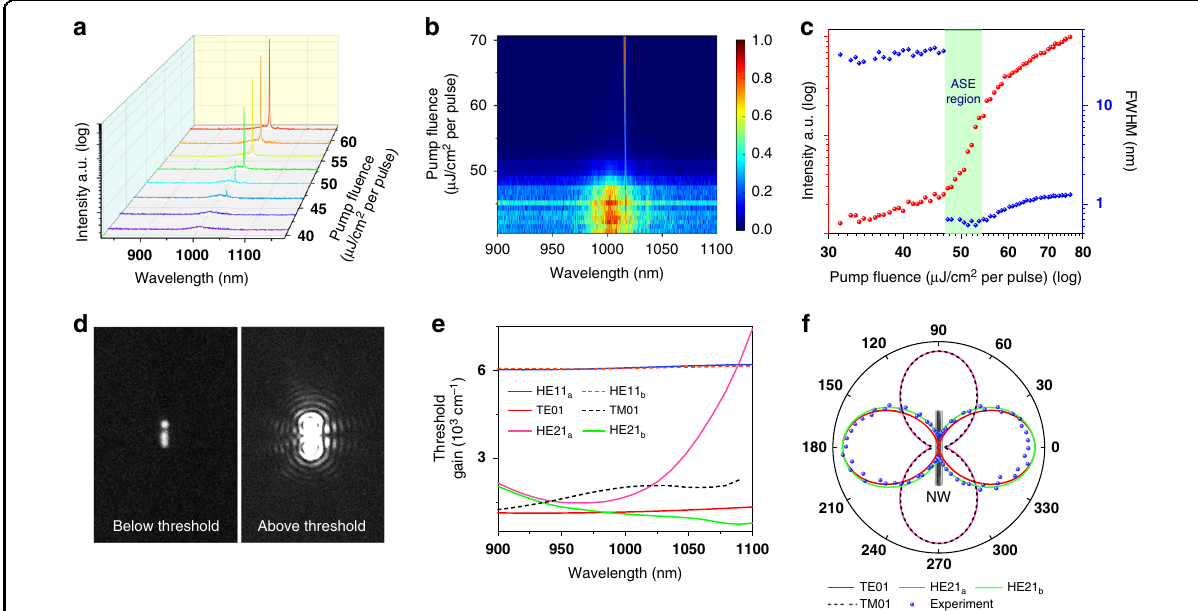
Fig. 2 Lasing characteristics and mode identi fi cation of the NW laser. a, b Emission spectra of the NW with increasing pump fl uences ( a ) and the normalized spectra map ( b ). c Integrated lasing peak intensity (red dots) and the corresponding FWHM (blue dots) of the emission spectra versus pump fl uence on a log – log plot. The ASE region is highlighted by the light green shaded area. d Optical images of the NW emission below (left) and above (right) the lasing threshold. e Calculated threshold gain spectra for supported guided modes of the core/shell NW with a diameter and length of 410 nm and 4.4 μ m, respectively. f Polarization dependence plots of possible lasing modes calculated from 3D FDTD simulations and the experimentally measured